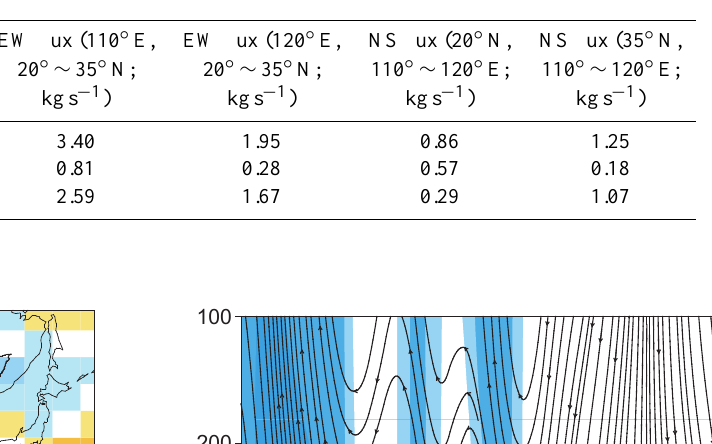
Table 1. Summer (JJAS average) OC column burden, wet deposition, and mass fluxes (1000 ∼ 500hPa) in EmisSA1998 and EmisSA2002 over southern China (110 ◦ ∼ 120 ◦ E, 20 ◦ ∼ 35 ◦ N).